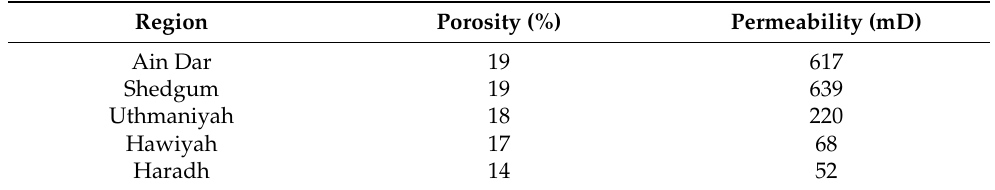
Table 1. Porosity and permeability in the Ghawar oilfield [19].